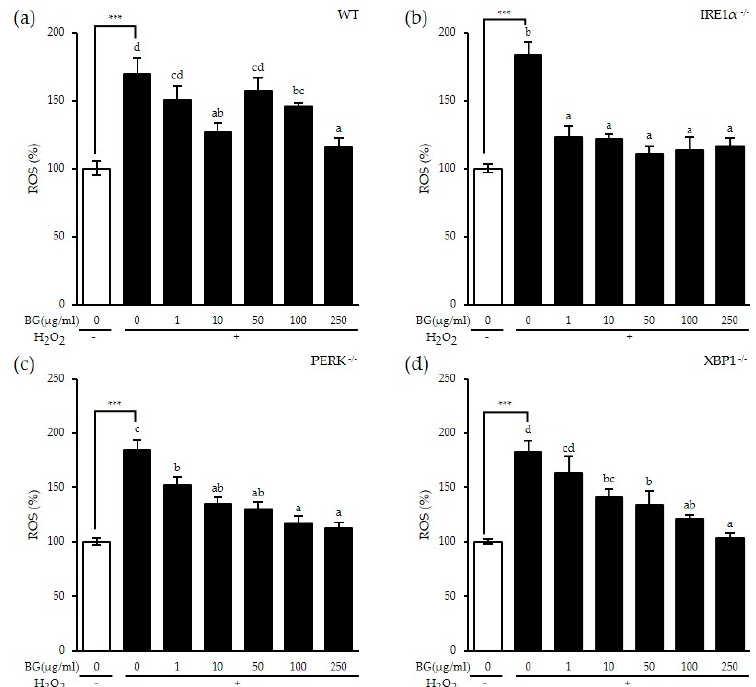
Figure 3. Inhibitory effect of BG on H 2 O 2 ‐ induced reactive oxygen species (ROS) production in an IRE1 α‐ dependent way. The ( a ) wt, ( b ) IRE1 α KO, ( c ) PERK KO and ( d ) XBP1 KO MEF cell lines were pretreated with various concentrations of BG for 24 h followed by H 2 O 2 stimulation for an additional 1 h. ROS level was determined using 2 ′ , 7 ′‐ dichlorofluorescein diacetate (DCFH ‐ DA) analysis. Data are shown as the means ± SD of three independent experiments. Significant differences between different concentrations were analyzed using Duncan’s multiple range test with one-way ANOVA and values labeled with different letters are significantly different ( p < 0.05). Student’s t -test was performed to assess the difference between the control group and the H 2 O 2 -treated group in the absence of BG. *** p < 0.001. White bar represents negative control. BG, black ginseng.